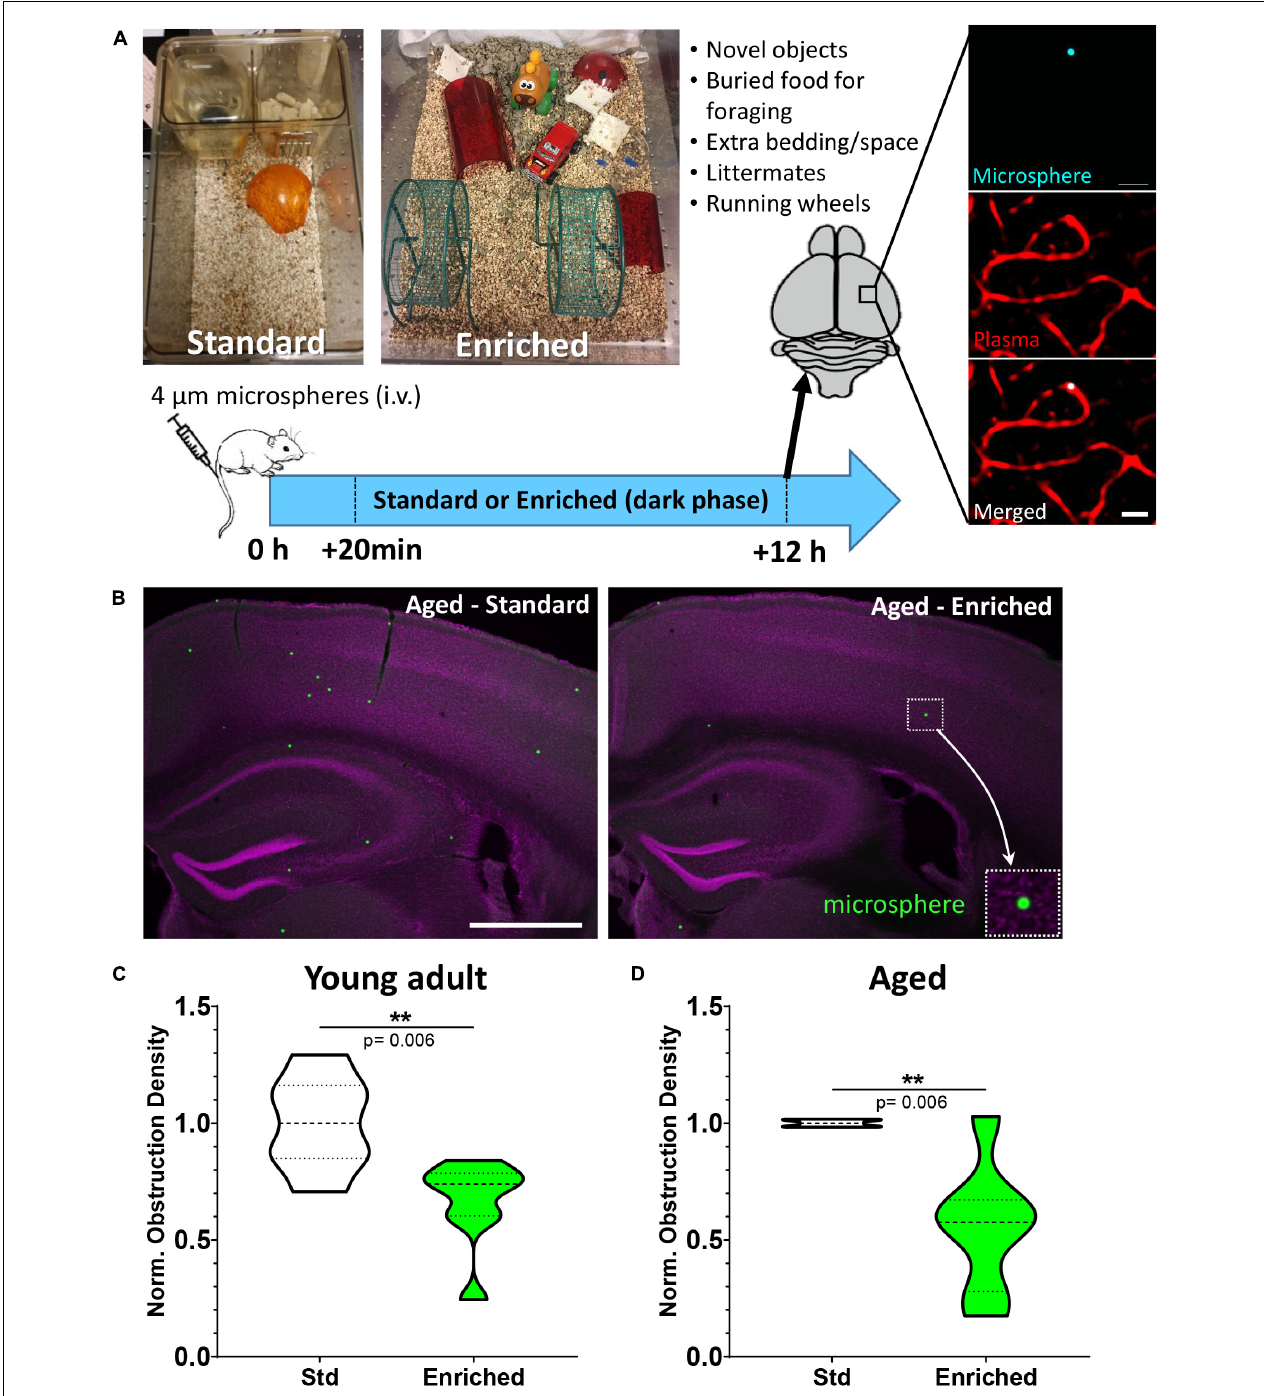
FIGURE 1 | Environmental enrichment enhances capillary recanalization in the cortex of young adult and aged mice. (A) Images show standard and enriched cages and timeline of experiments. Far right panel shows ex vivo confocal images of a microsphere lodged within the lumen of a capillary. (B) Representative images of microspheres distributed across cortical and subcortical regions 12 h after injection in aged mice exposed to standard or enriched environment (microspheres pseudocolored in green, magenta represents DAPI labeling). (C) Normalized cortical microsphere density for young adult mice housed in standard or enriched cages [ n = 7 and 8 mice, respectively; unpaired t test t ( 13 ) = 3.31, p = 0.006]. (D) Microsphere obstruction density in 16–19 month old male (8) and female (4) mice placed in either standard ( n = 5) or enriched ( n = 7) cage for 12 h. Data was normalized to the mean cortical obstruction density of standard housed mice for each independent cohort. Aged mice exposed to enrichment had a significant reduction in cortical obstructions [0.56 ± 0.28, t ( 10 ) = 3.51 p = 0.006]. ** p < 0.01. Scale bars = 20 µ m (A) or 1 mm (B) .